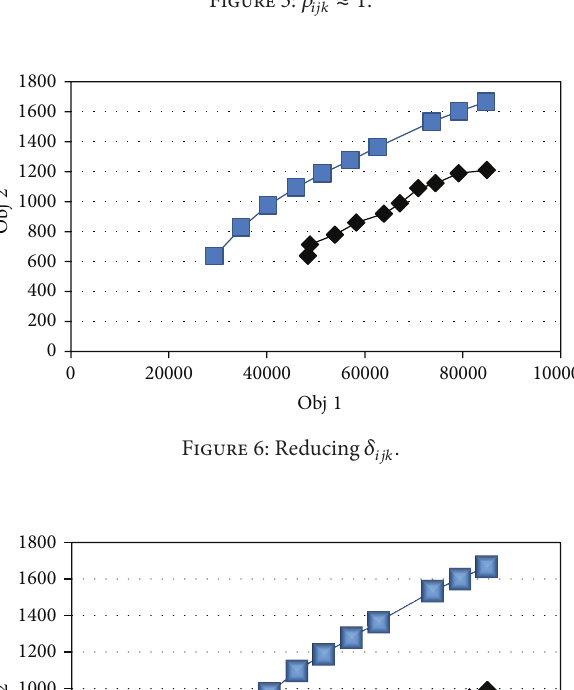
Figure 5: 𝜌 𝑖𝑗𝑘 ≈ 1 .